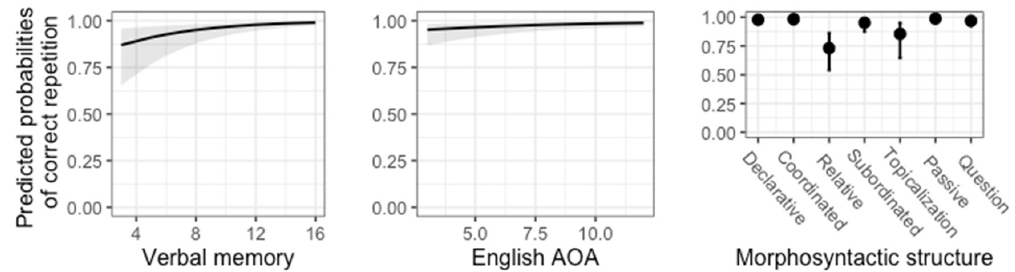
Figure 6. Predicted probabilities of a correct response given each fixed effect in the optimal model of Arabic T1, predicting correct repetition of target morphosyntactic structure.